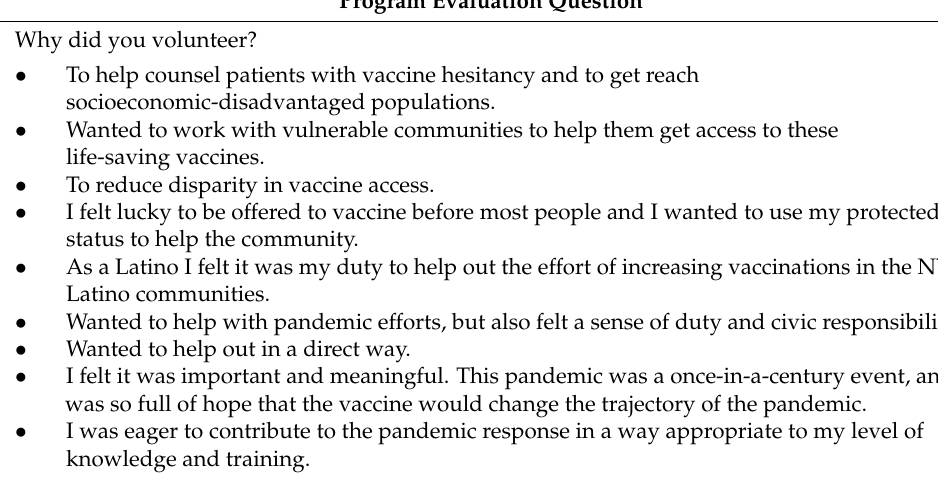
Table 4. Student perceptions of the vaccination program. Program Evaluation